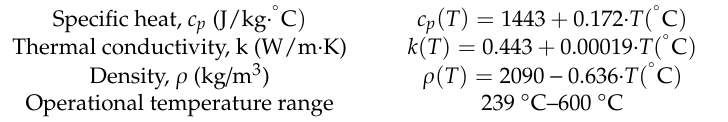
Table A3. Thermal properties of storage salt [50].